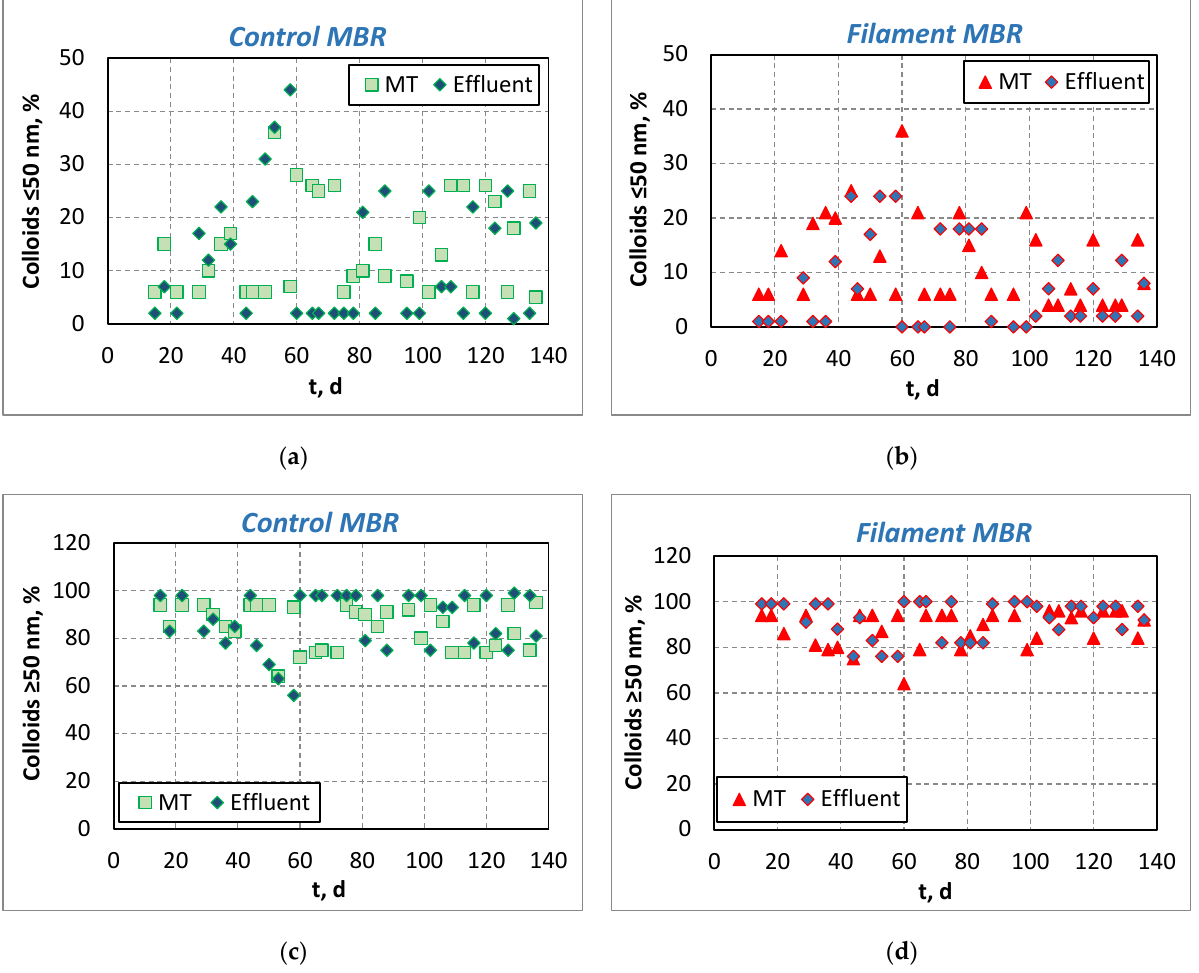
Figure 4. Evolution of colloids in the membrane tank (MT) and in the effluent of the pilot-scale MBR: ( a ) colloids with size ≤50 μ m in the Control-MBR, ( b ) colloids with size ≤50 μ m in the Filament-MBR, ( c ) colloids with size ≥50 μ m in the Control-MBR and ( d ) colloids with size ≥50 μ m in the Filament-MBR.